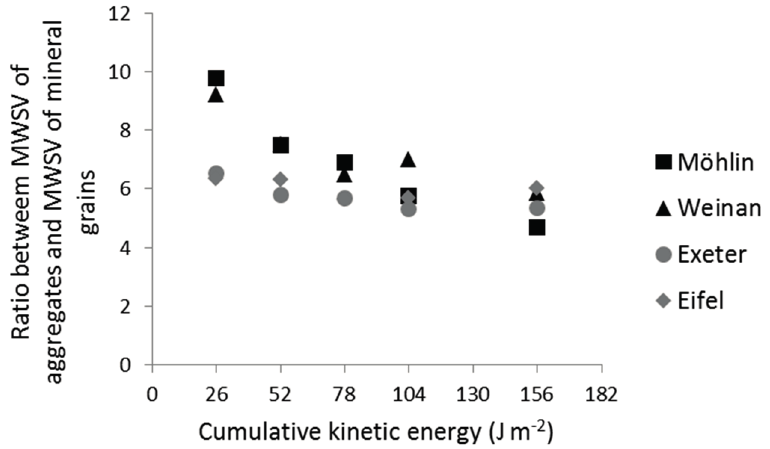
Figure 5. The ratios between Mean Weight Settling Velocity (MWSV) of aggregates and MWSV of mineral grains as cumulative kinetic energy